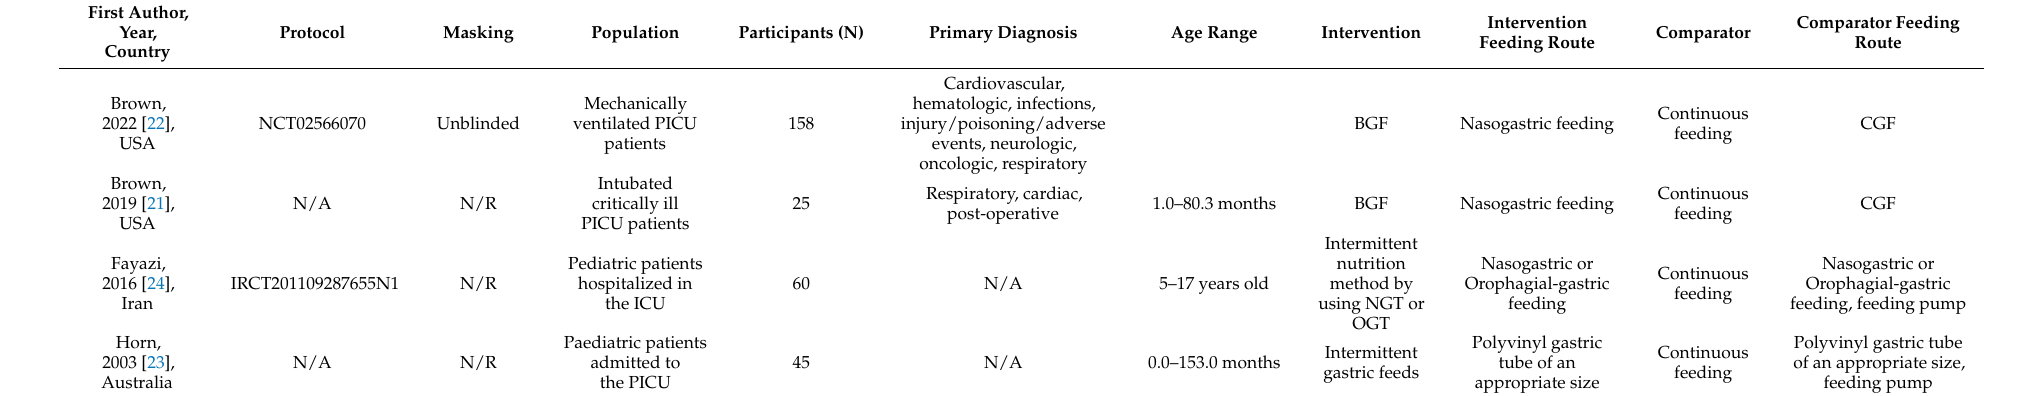
Table 1. Characteristics of the included